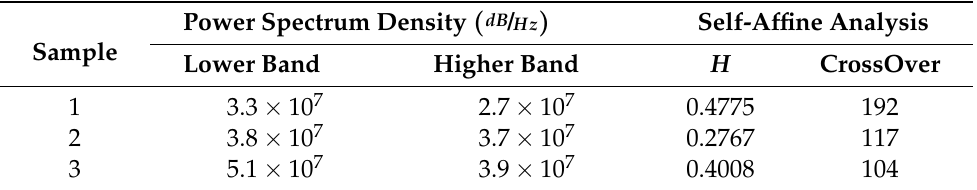
Table 1. Summary of the experimental results of Experimental Design. Low Frequencies 0.5–12 Hz band and High Frequencies 12–60 Hz band. Average values of the scaling exponent H